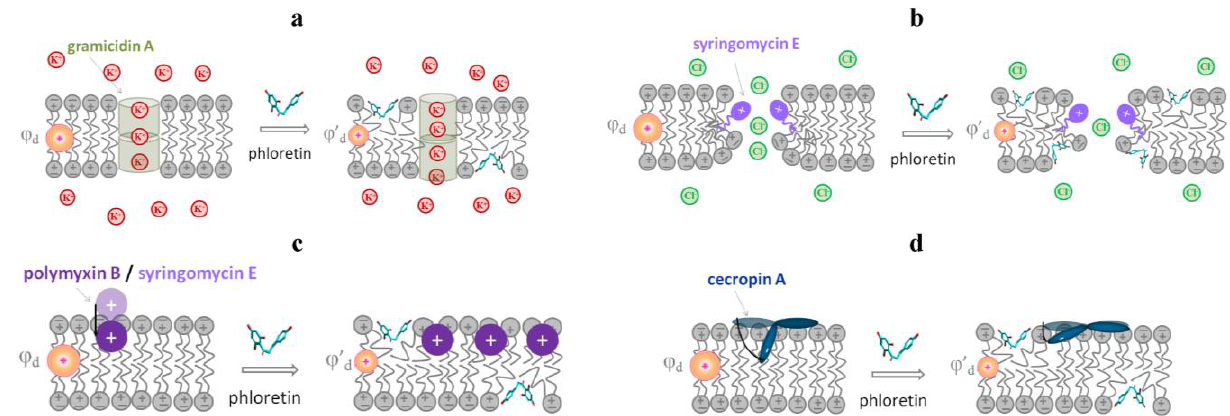
Figure 9. Schematic representation of the changes in the pore-forming activity of anti-microbial agents induced by decrease in the membrane dipole potential at phloretin’s addition: ( a ) an increase in the conductance of single cation-selective gramicidin A channels (colored with olive); ( b ) a decrease in the conductance of single anion-permeable syringomycin E channels (colored with violet); ( c ) facilitation of immersion of polymyxin B/syringomycin E cations (colored with purple) accompanied by an increase in the number of open channels; and ( d ) suppression of the immersion of the C-terminal domain of cecropin A (colored with dark cyan), resulting in a decrease in the number of cecropin A channels.